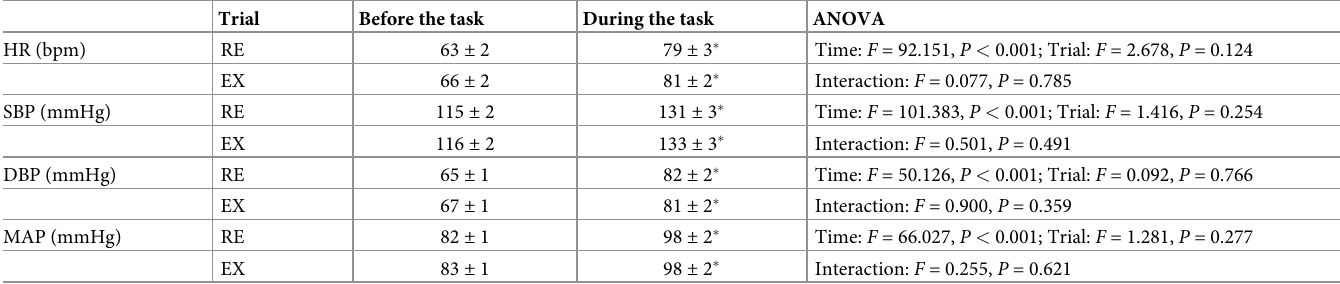
Table 1. Hemodynamic variables before and during the MS